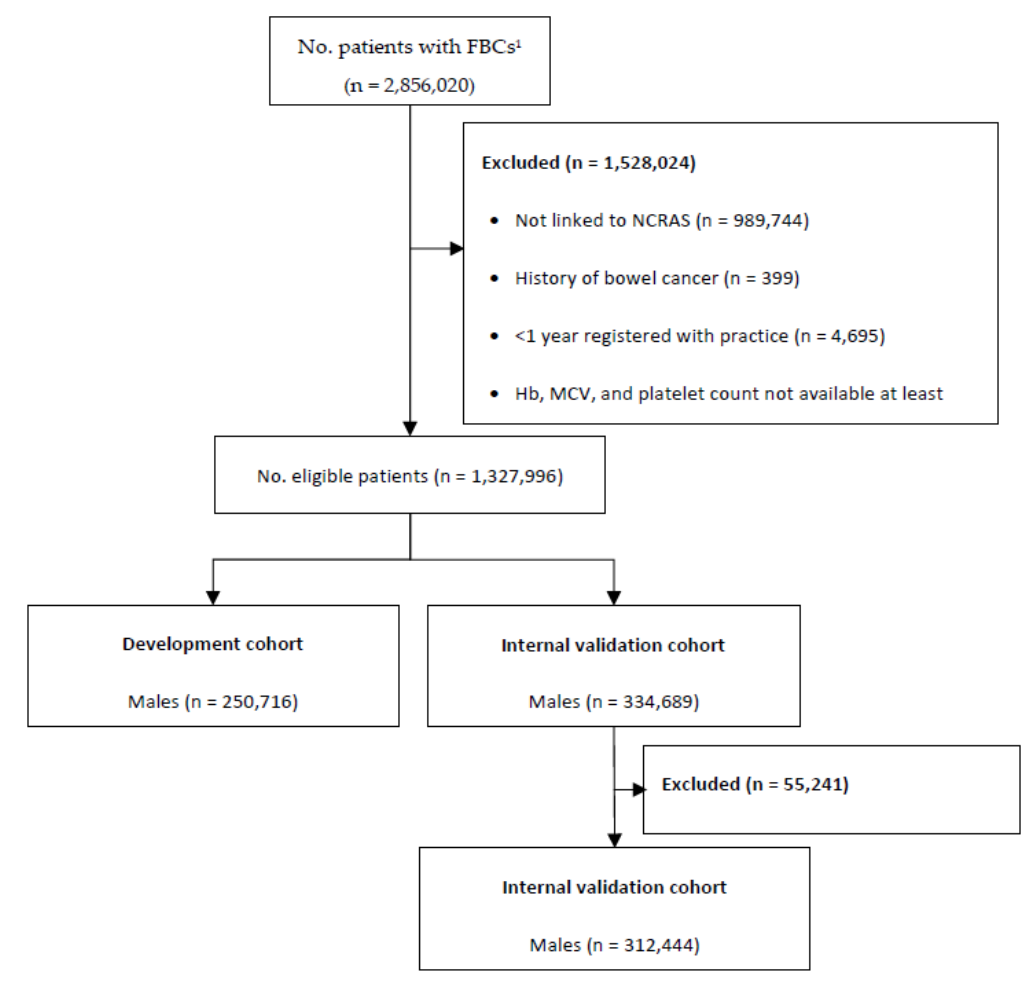
Figure 2. Patient flow diagram. 1 Number of patients available in the CPRD data extract. Abbreviations: FBC = full blood count; NCRAS = National Cancer Registration and Analysis Service; Hb = haemoglobin; MCV = mean corpuscular volume.